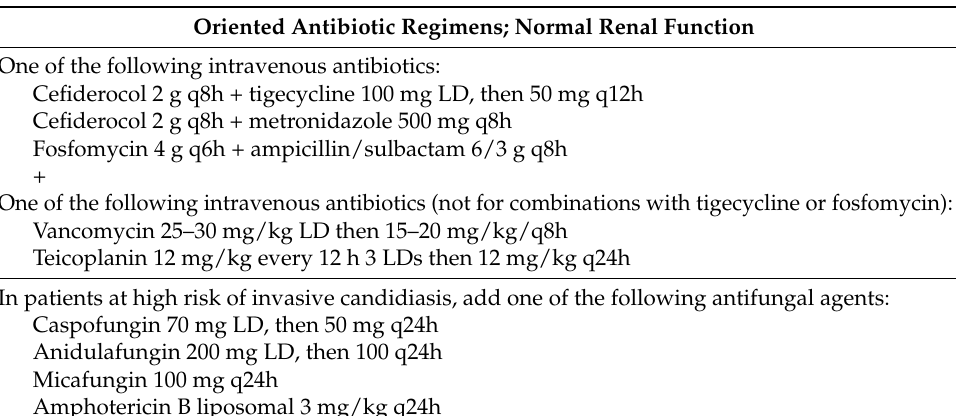
Table 8. Patients with IAIs with known colonisation by carbapenem-resistant A. baumannii . Oriented Antibiotic Regimens; Normal Renal